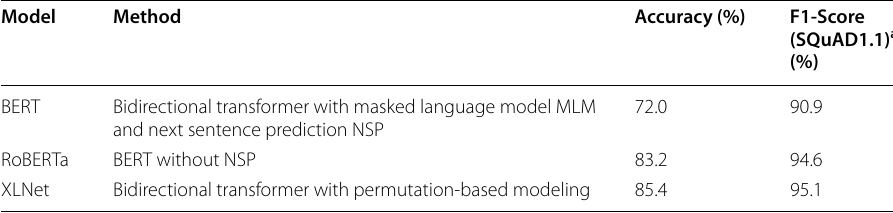
a SQuAD1.1 is a large‑scale dataset contains questions and